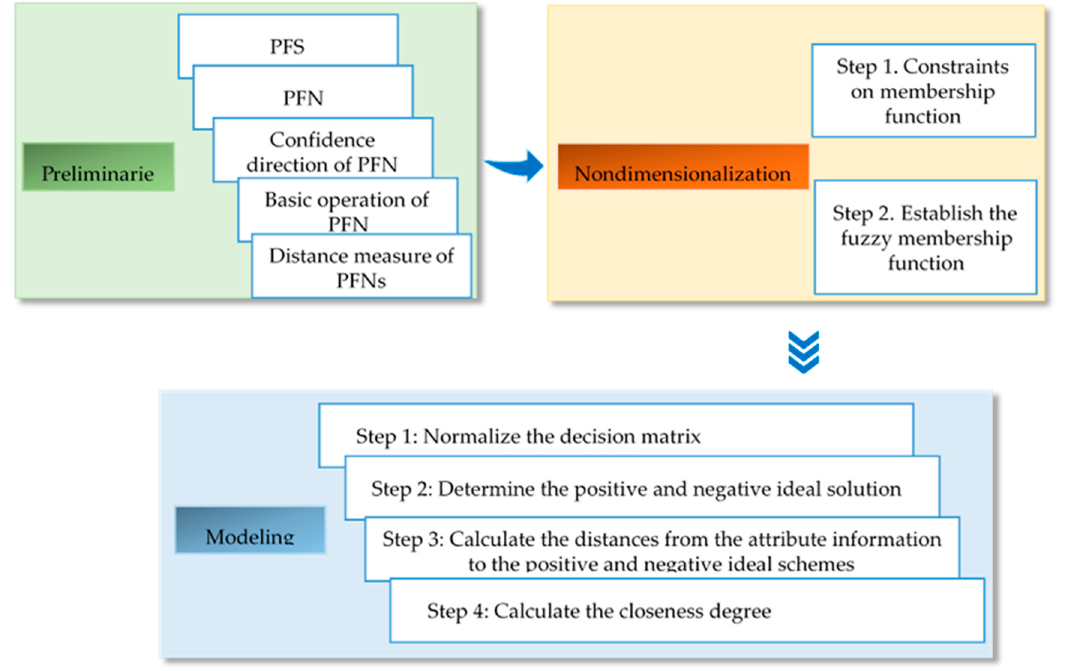
Figure 3. Structure of research method.